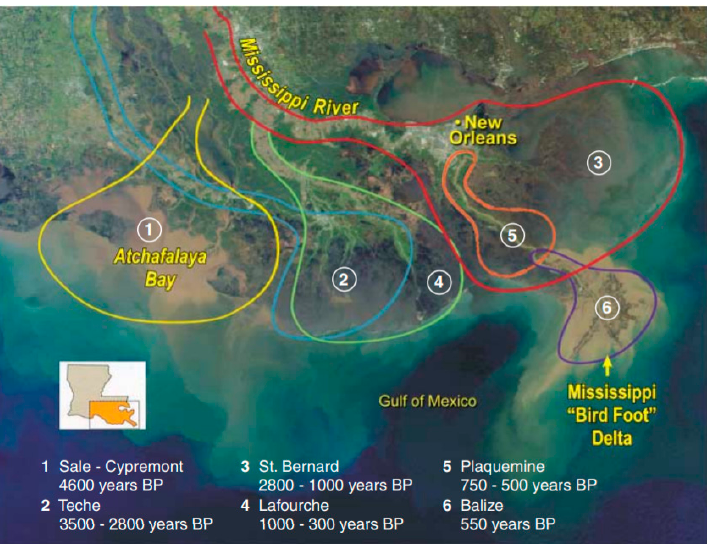
Figure 1. Mississippi River Delta Holocene history of delta growth (from [16], modified from [33]).